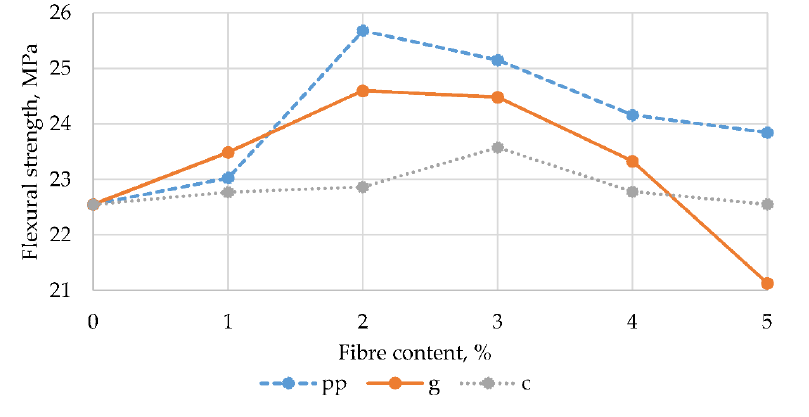
Figure 4. The dependence of flexural strength on the content and type of fibres.